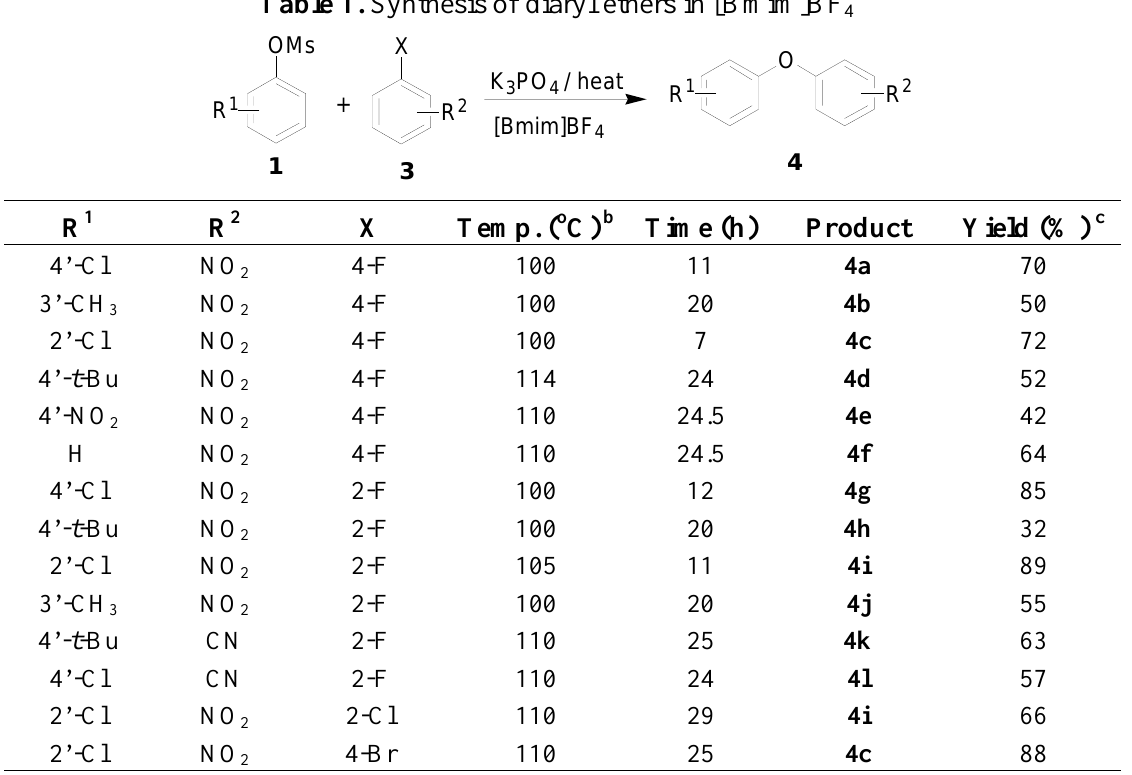
Table 1. Synthesis of diaryl ethers in [Bmim]BF